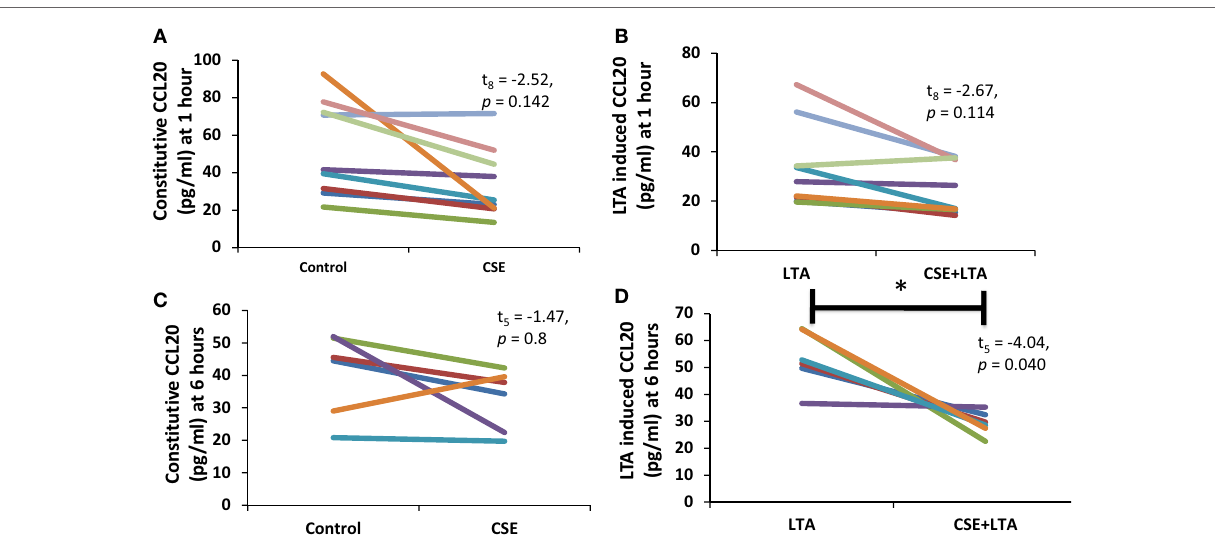
FigUre 6 | Phnec basolateral secretion of ccl20 significantly decreased following cse exposure at the 6-h time point in lTa-induced samples. Depicted in this figure are basolateral CCL20 secretions from PHNECs cultured from non-smoke-exposed individuals at 1 (a,B) and 6 h (c,D) post-LTA stimulation. PHNECs were exposed apically to cigarette smoke extract in ALI media for 3 h, LTA and control treatments received ALI media only. CSE was then removed by suction and cells were rinsed twice with PBS. Subsequently, LTA and CSE + LTA treatments were stimulated apically with LTA from B. subtillis (10 μ g/mL) in ALI media by applying 300 uL in the apical compartment. Supernatants were harvested at 1 and 6 h post-LTA stimulation. CCL20 was quantified by ELISA.